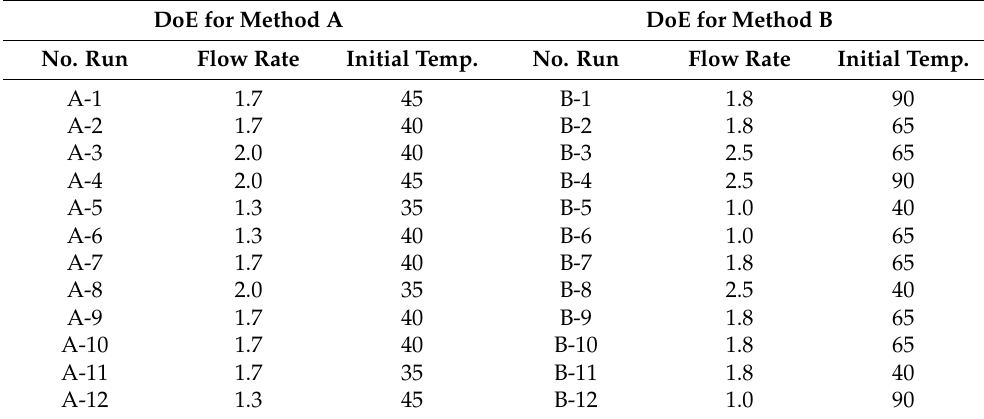
Table 4. DoE for optimization.